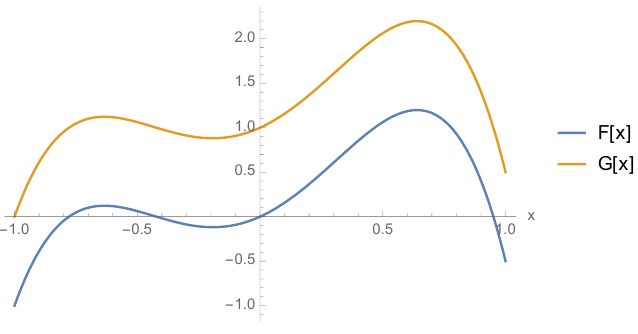
Figure 27 . Plot of F ( x ) and G ( x ) for the values z = 2 ; (cid:22) = 3 ; (cid:23) = 1 =